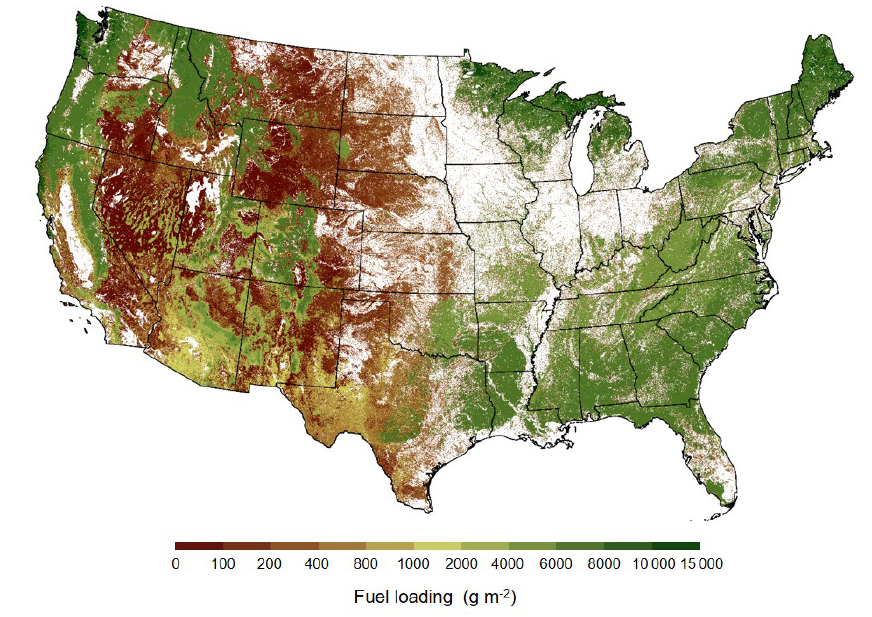
Figure 9. Map of best-estimate fuel loading for forest and rangeland in gm − 2 .